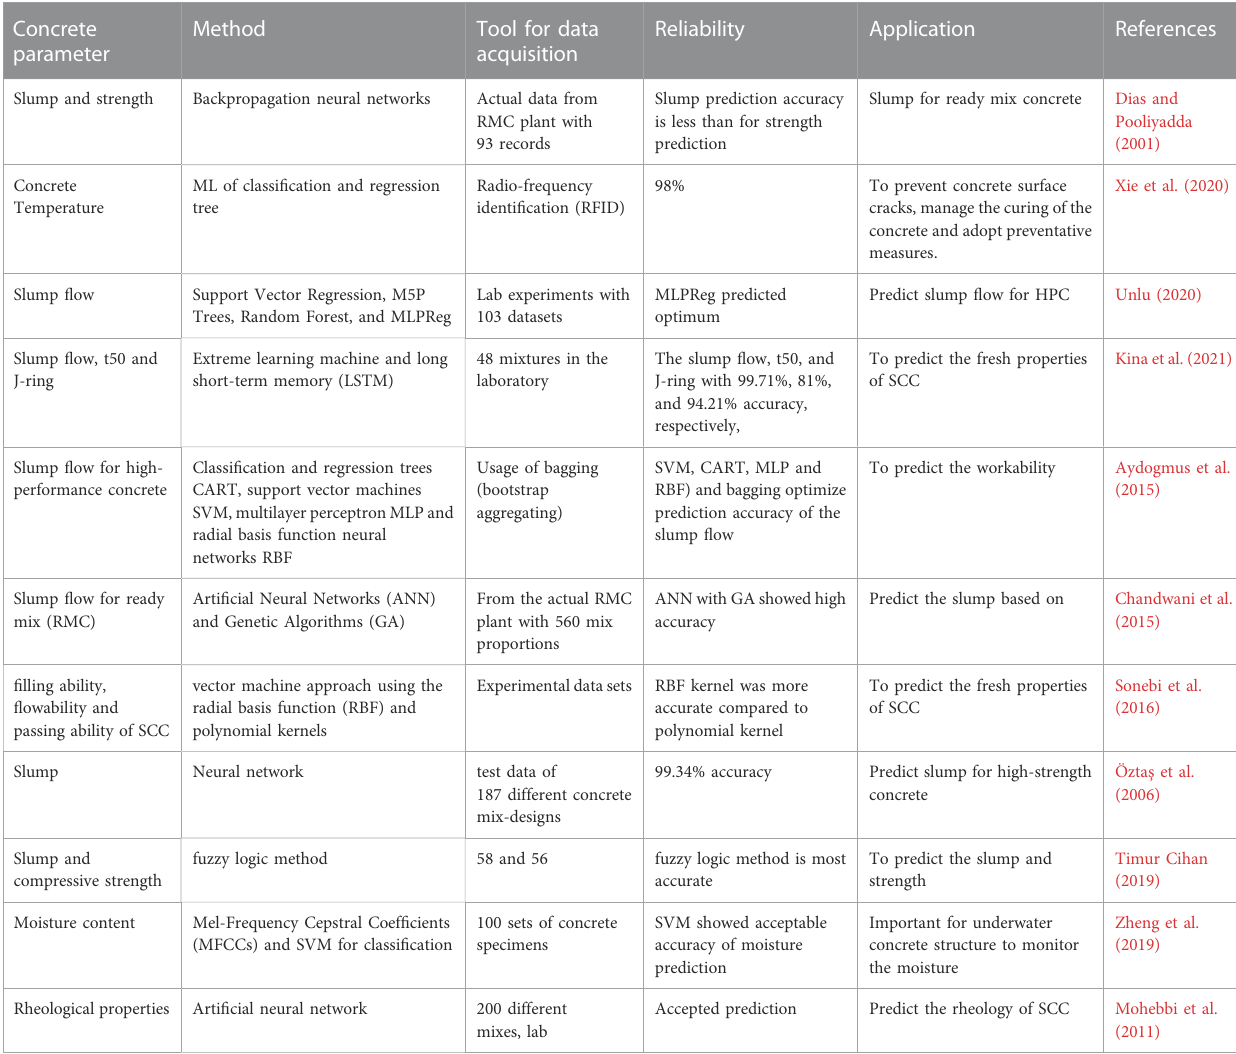
TABLE 2 ML for fresh concrete properties